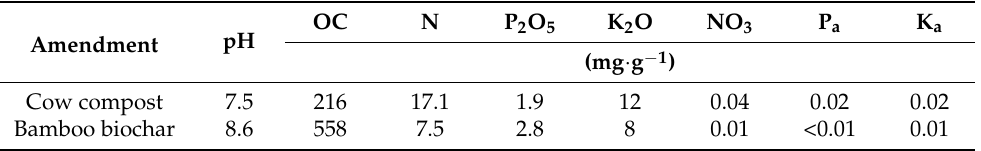
Table 2. Chemical properties of organic amendments (P 2 O 5 and K 2 O refer to total contents, while P a and K a are available